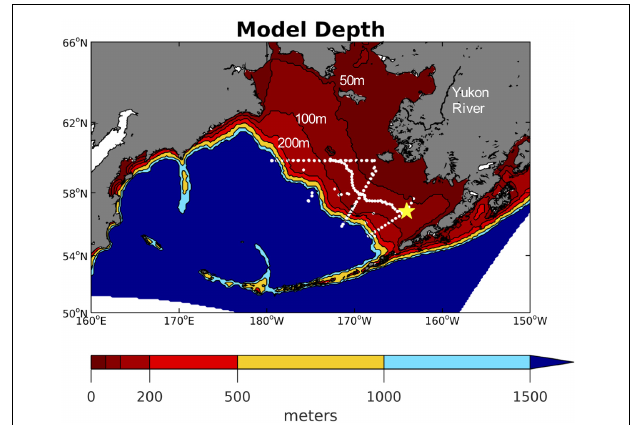
FIGURE 1 | Model domain with contoured color shading for model depth. The contour lines for the 50, 100, and 200 m isobaths are also labeled as these represent the generalized boundaries for the inner, middle, and outer Bering Sea shelf domains. White dots signify station locations from the 2008–2010 BEST-BSIERP cruises and the yellow star signifies the locating of the M2 mooring.